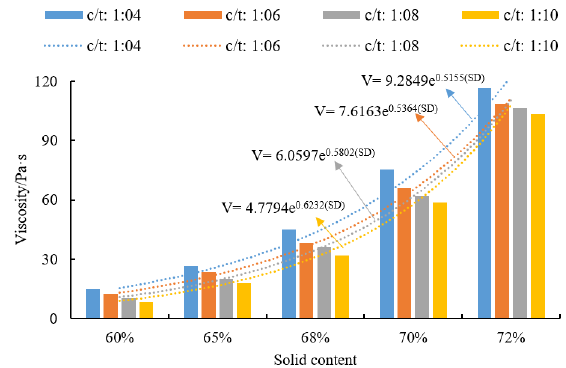
Figure 7. Histogram between solid content and viscosity of CTB samples.